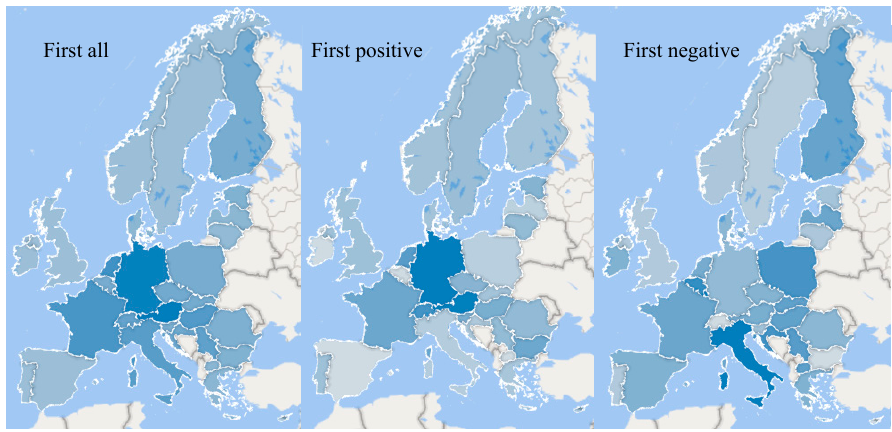
Figure 18. Number of precedence by country, first precedencies, group EM by effect. Geospatial distribution.